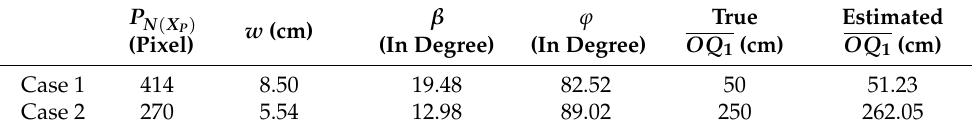
Table 2. Estimation results of distance to the